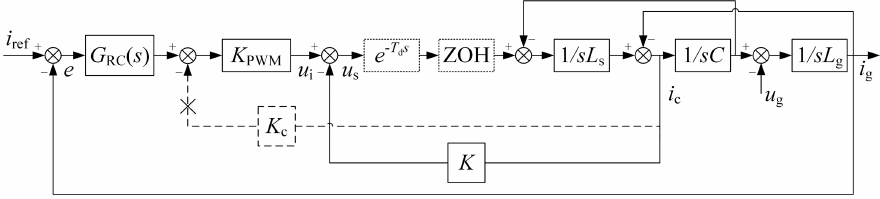
Figure 2. Block diagram of the single-phase current control system.